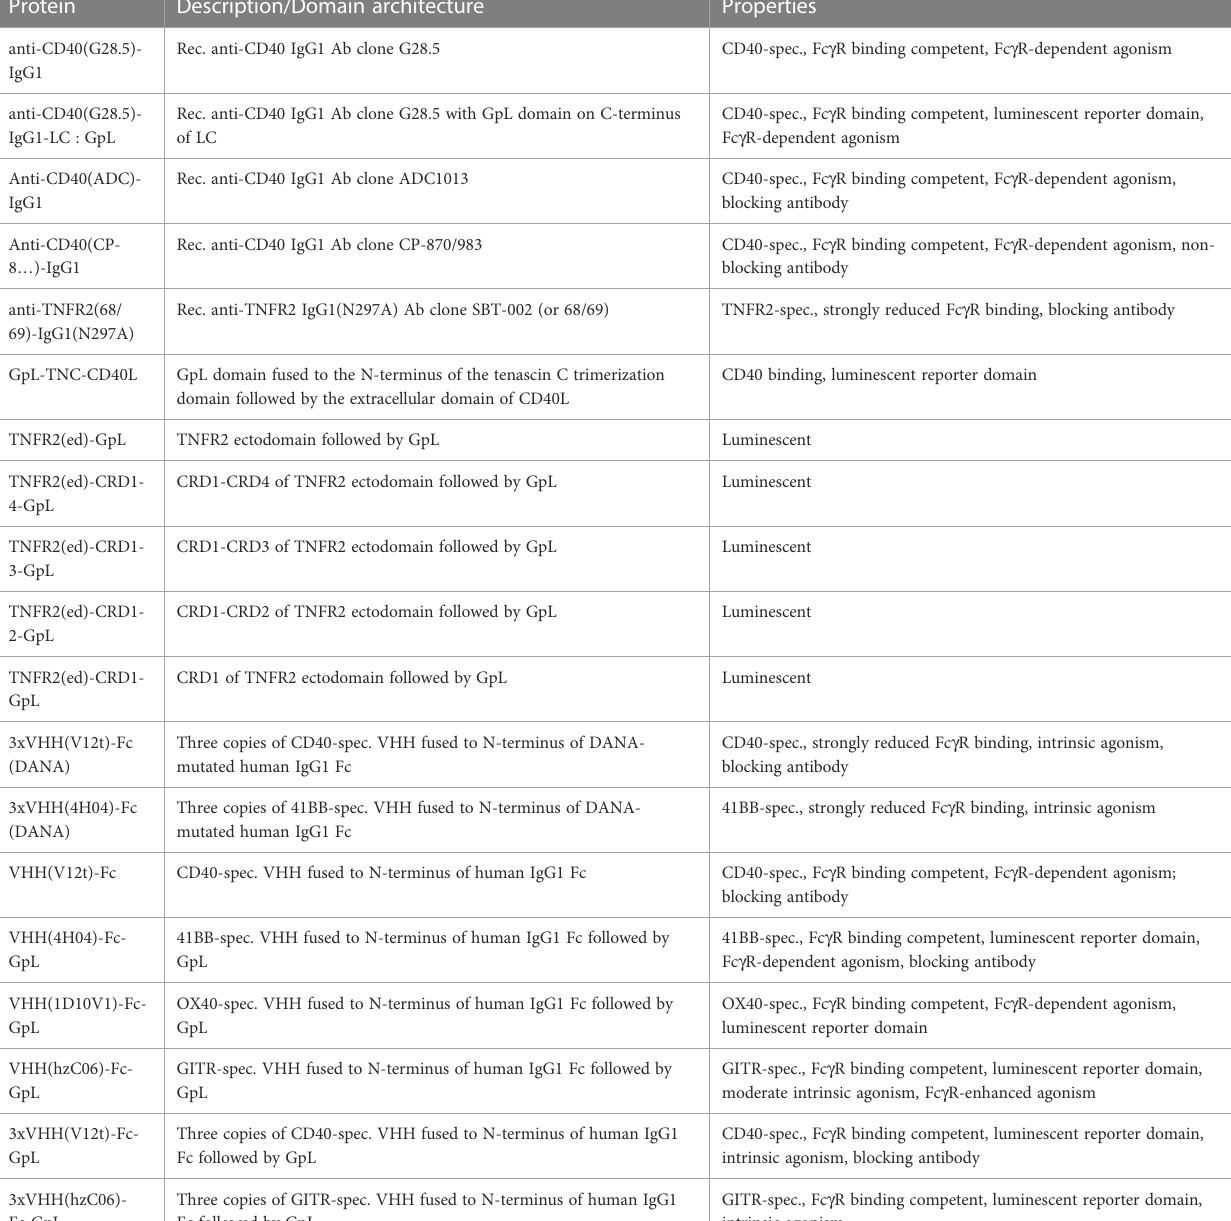
TABLE 1 Domain architectures and properties of the recombinant proteins used in this work. Protein Description/Domain